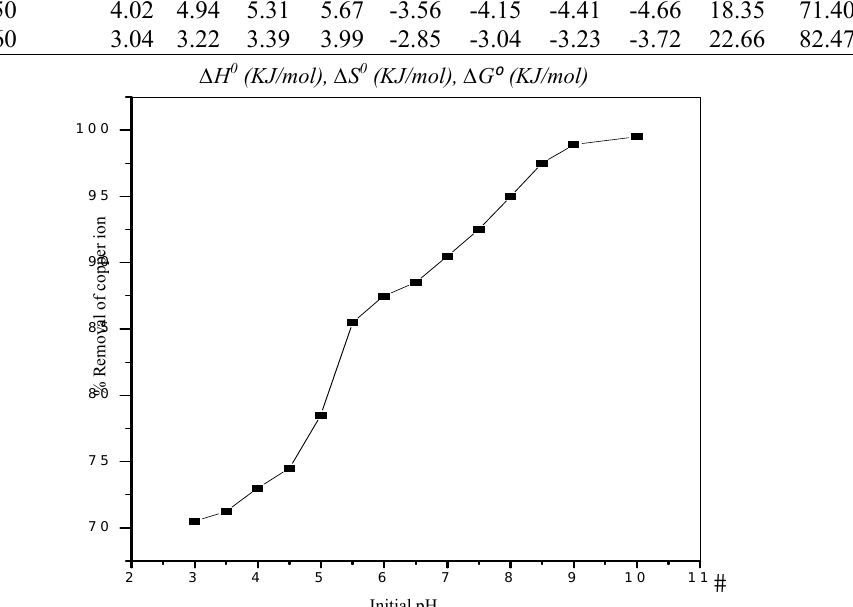
Figure 8. Effect of pH on the adsorption of copper ion CBC [Cu]=30 mg/L; Contact time =60 min; Adsorbent dise=25 mg/50 mL; Temp=35 o